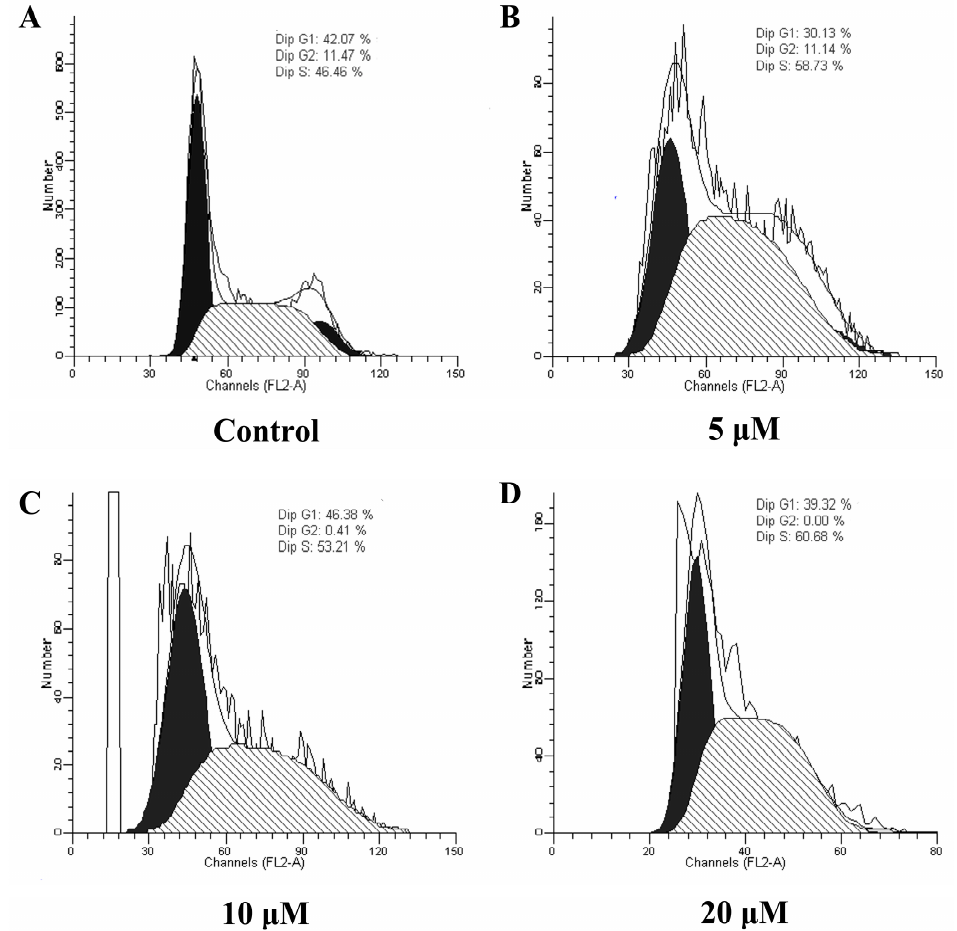
Figure 2. Flow cytometry analyses of cell cycle distribution of HepG-2 cancer cell after treatment of compound 2n (5.0 Mm ( B ), 10.0 µ M ( C ), 20.0 µ M ( D ), and no treatment (Ctrl) ( A ) as a reference control for 48